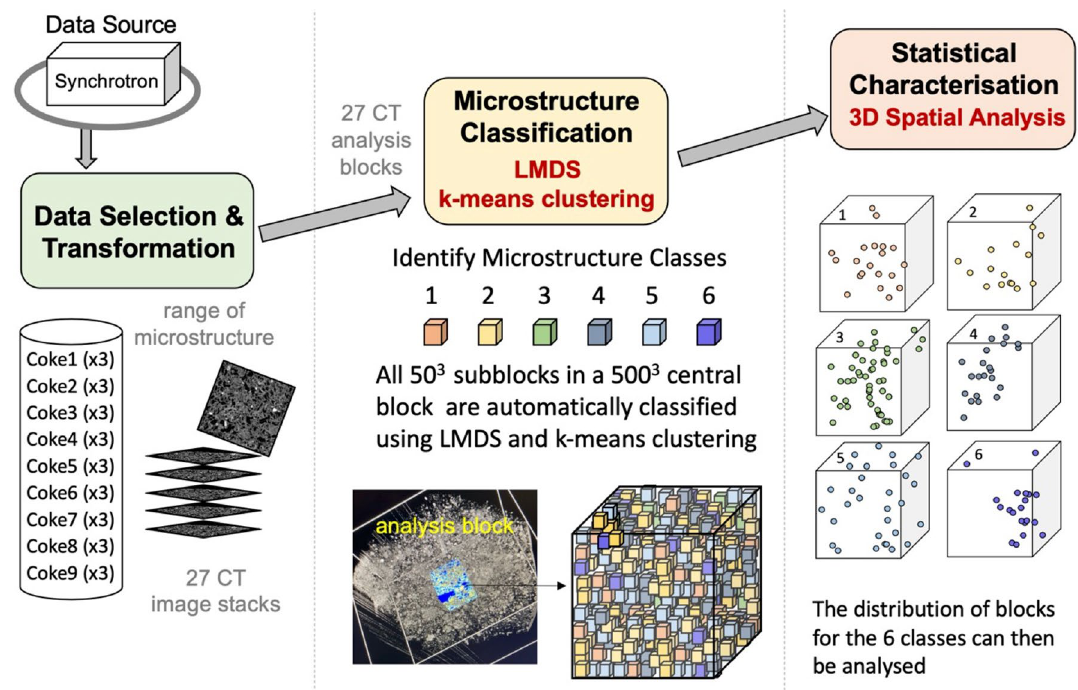
Fig. 1 An overview of the suggested process for characterising cokes based on the distribution of automatically classified blocks of microstruc- ture. This study describes the classification